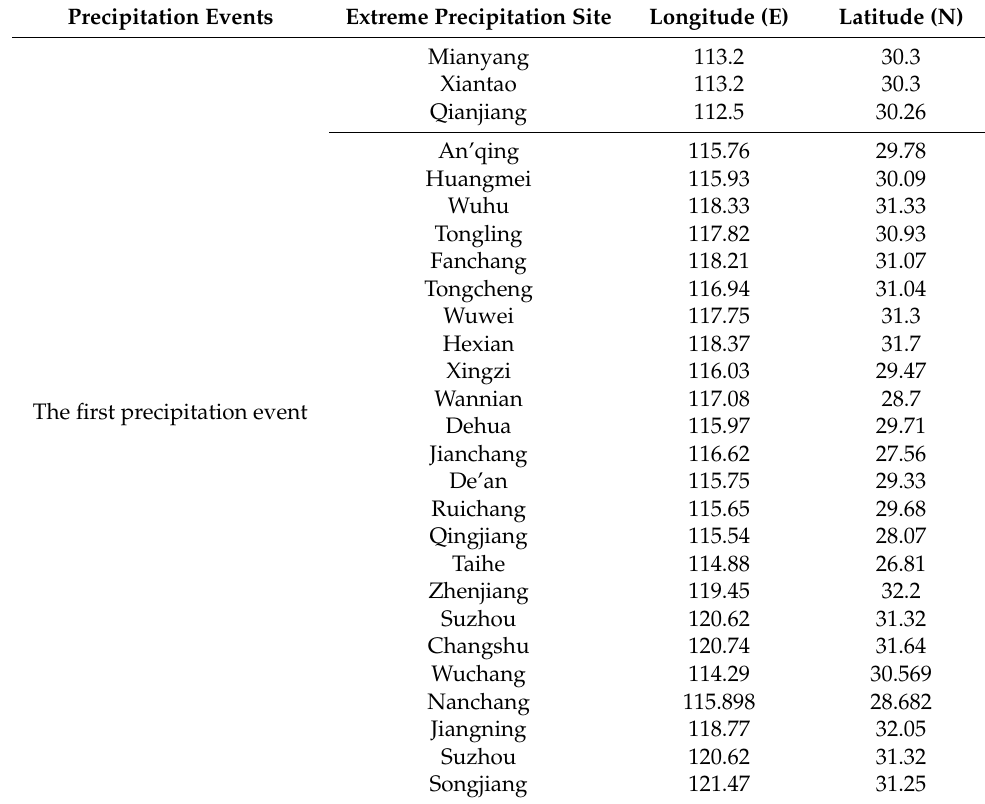
Table A1. The extreme precipitation sites of Meiyu period in